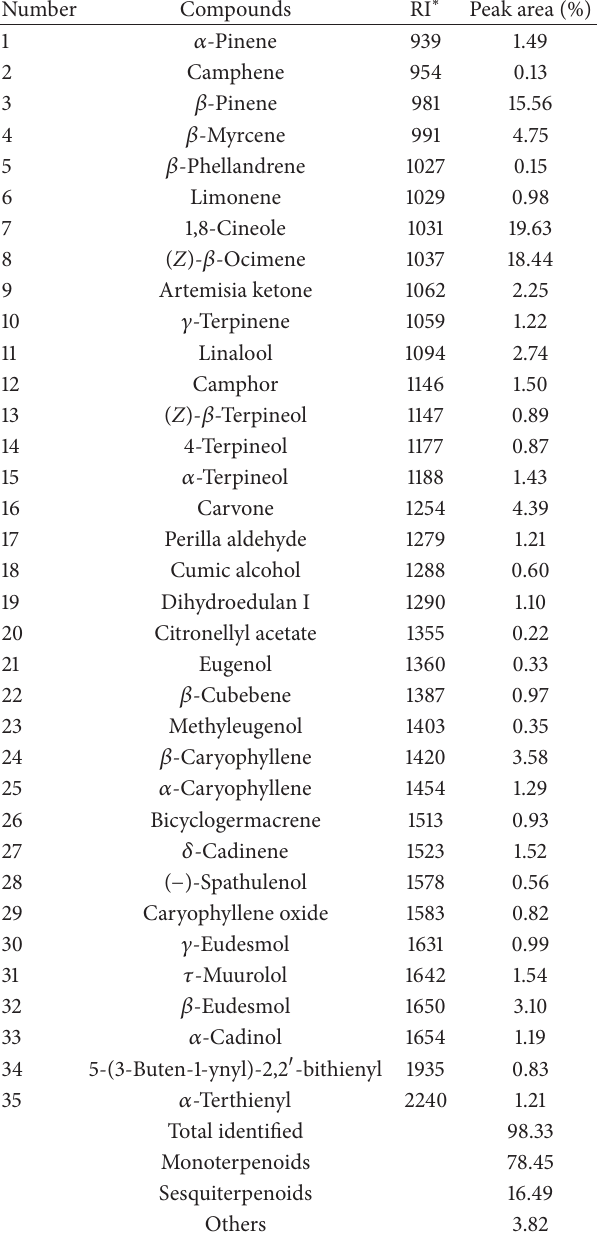
Table 1: Chemical constituents of essential oil derived from Echinops latifolius aerial